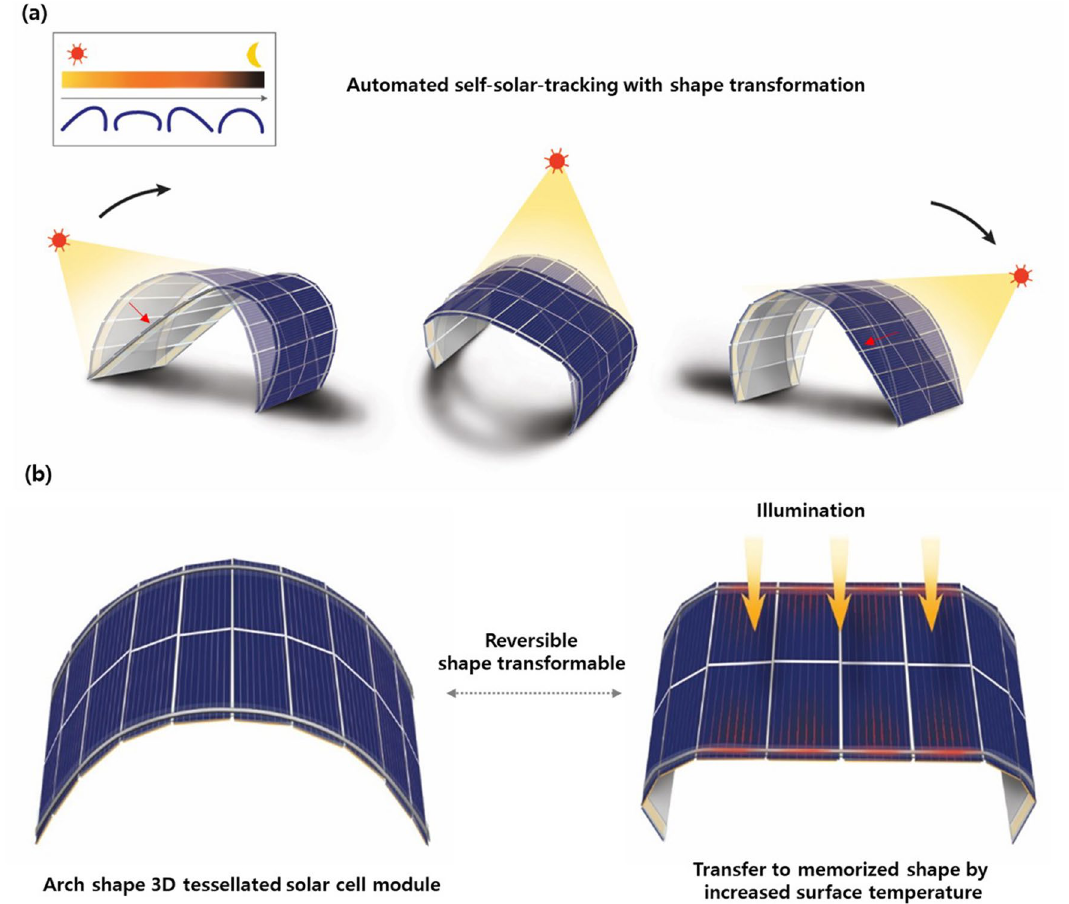
Figure 1. ( a ) Schematic illustration of the concept of automated self-solar-tracking using a shape- transformation 2D tessellated solar cell array during 1 day. ( b ) Schematic illustration of the mechanism of reversible shape transformation via transfer of the heat of the solar-cell surface induced by